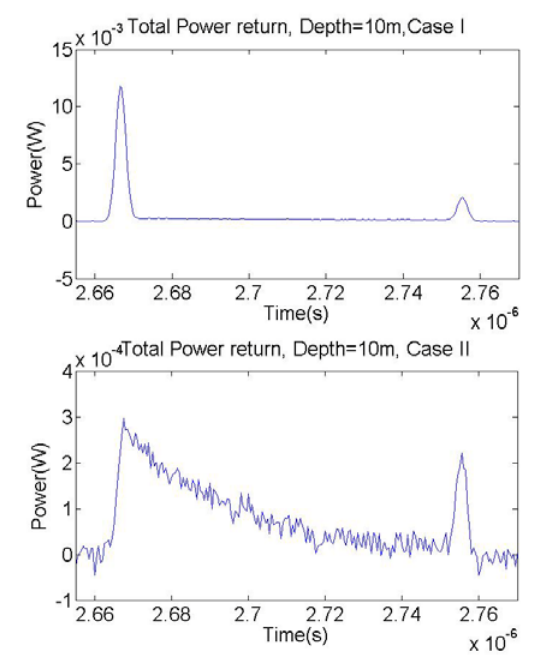
Fig.4 Comparison of total power return in Case I water and Case II water. The water depth is